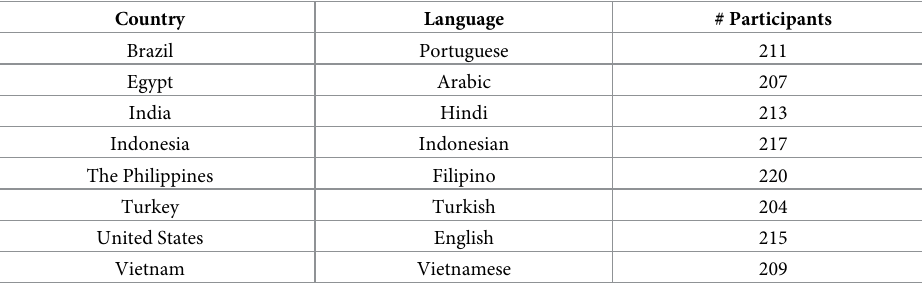
Table 1. Recruitment and translation details for each country in the